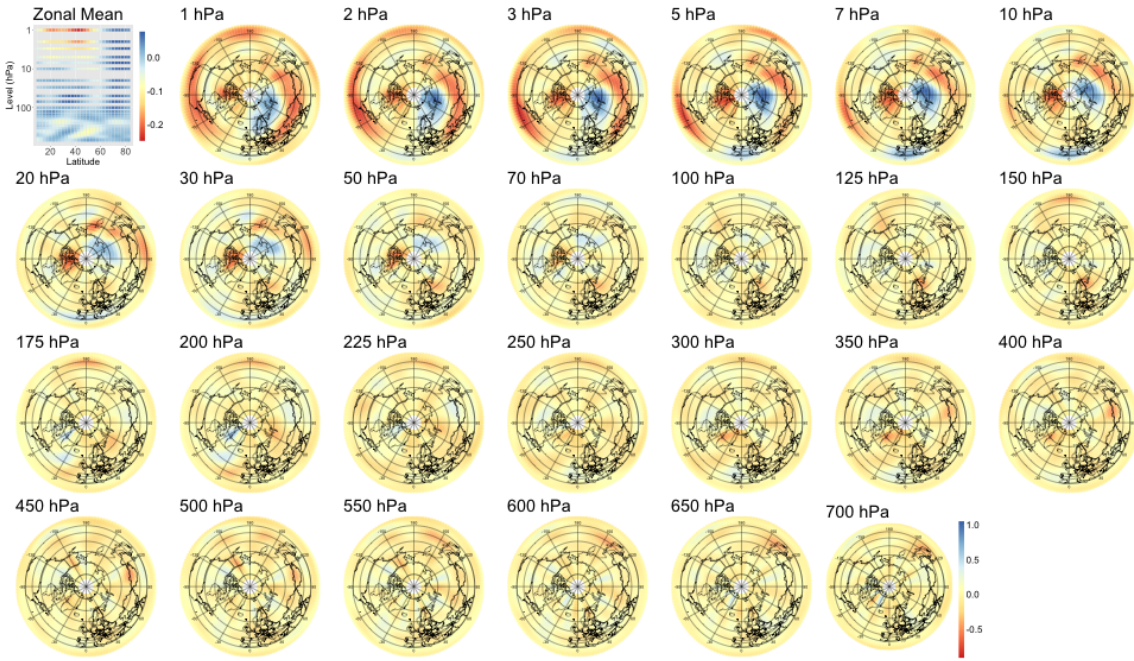
Figure B14. Patterns of heat flux maximizing correlation with the SSW index at a lead time of 44d. The upper-left plot displays the patterns’ zonal